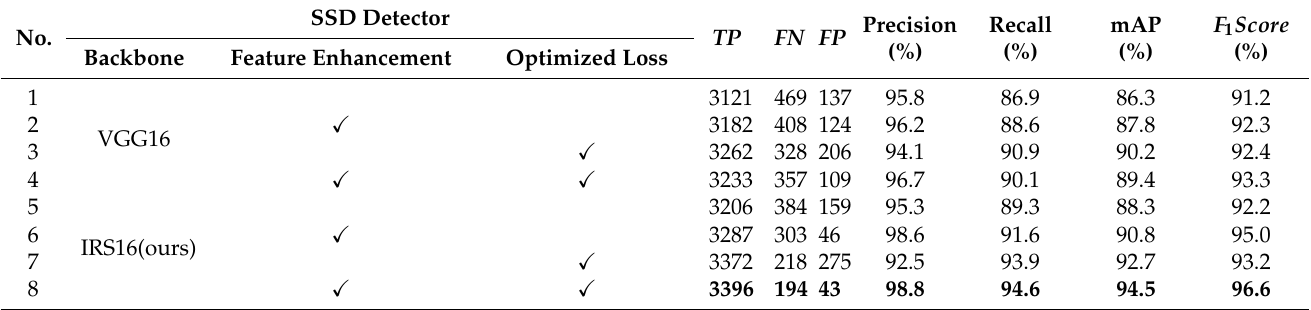
Table 2. Experiment results of detection methods with different